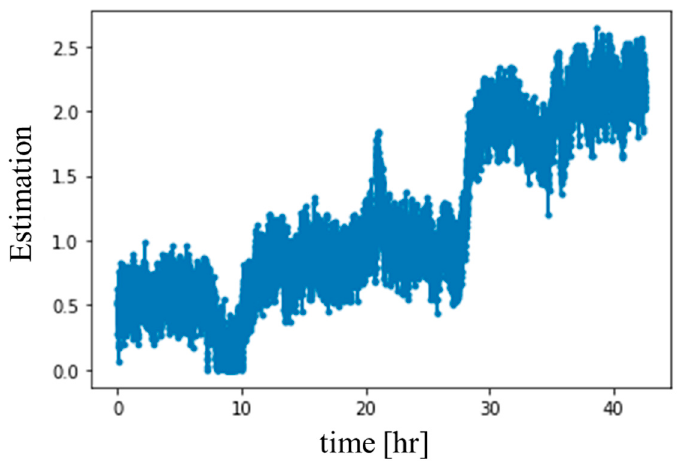
Figure 18. The continuous estimation